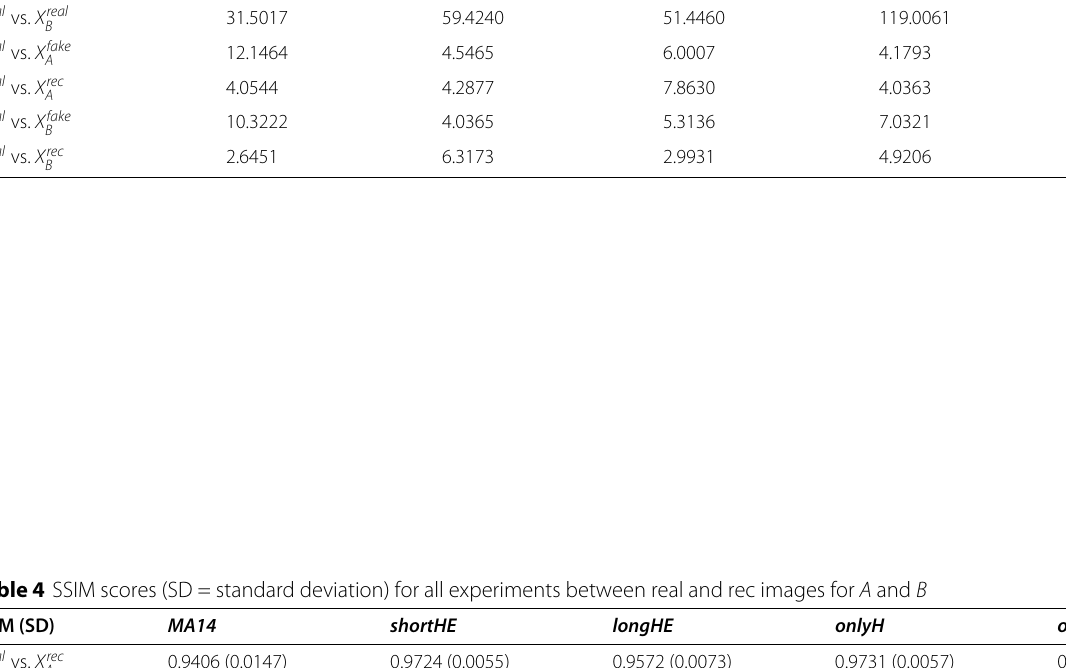
Table 3 FID scores for all experiments between real and generated (fake, rec) images for A and B FID MA14 shortHE longHE onlyH